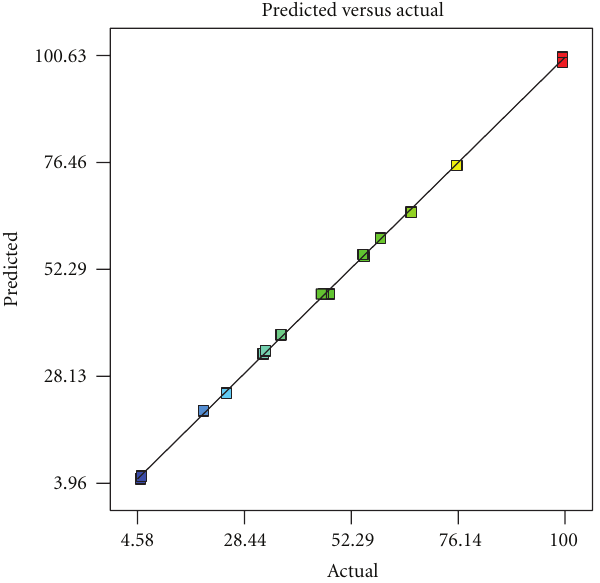
Figure 3: Plot of predicted versus actual values for % Cr(VI) removal.